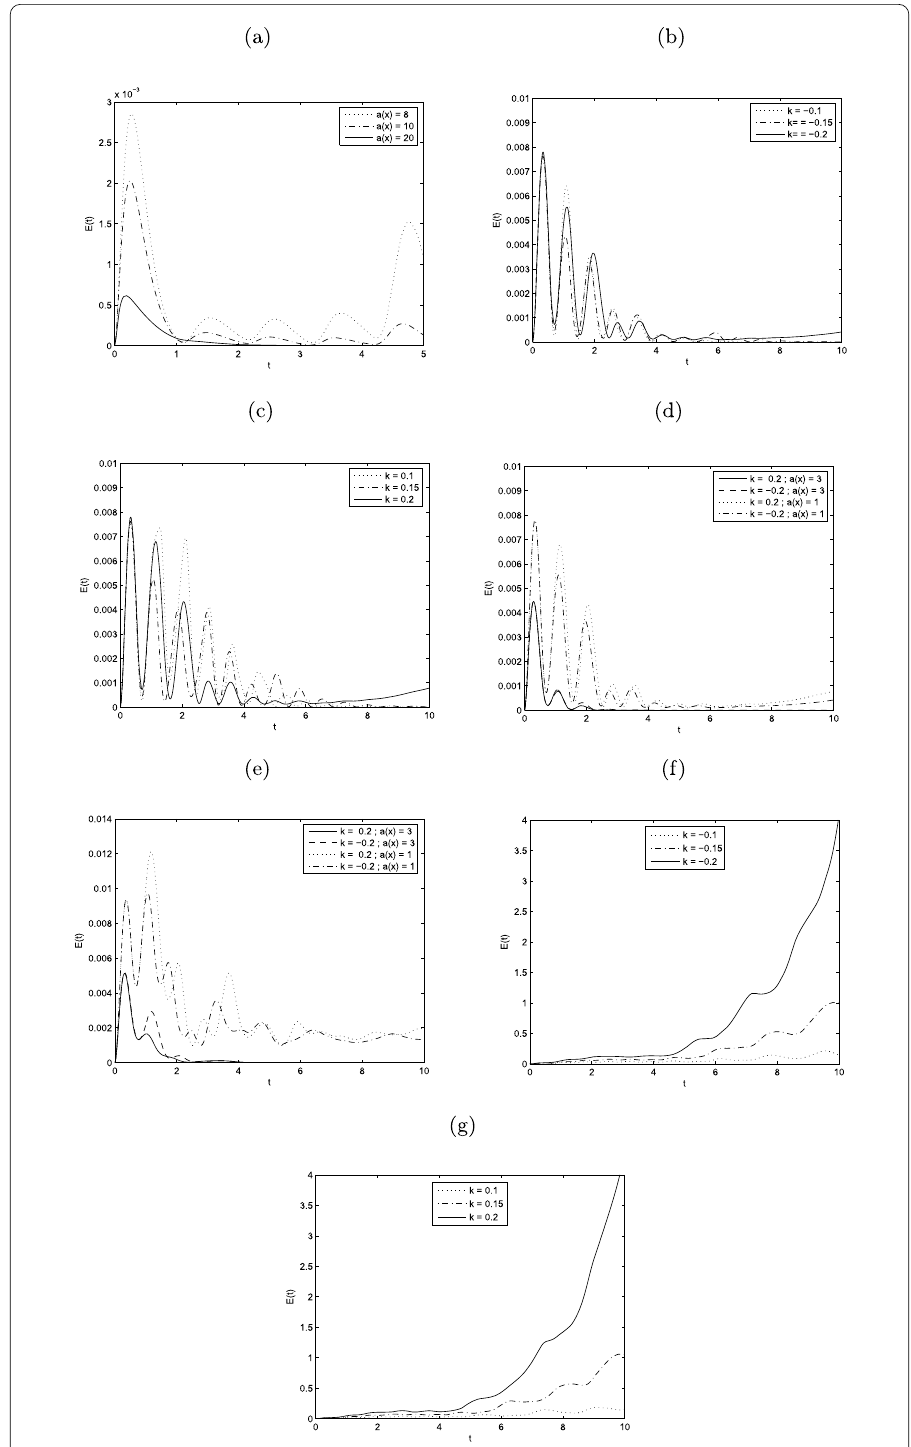
Figure 7 The energy E 0 ( t ) of the wave system (1.6)-(1.10) with: a) τ = 1 when k = –1, and for various a ( x ); b) τ = 1, k is negative and when a ( x ) = 1; c) τ = 1, k is positive and when a ( x ) = 1; d) τ = 1, a ( x ) = 1 and a ( x ) = 3, and for various k ; e) τ = 2, a ( x ) = 1 and a ( x ) = 3, and for different values of k ; f) τ = 3, a ( x ) = 0, and for several values of k ; g) τ = 3, a ( x ) = 0, and for k >